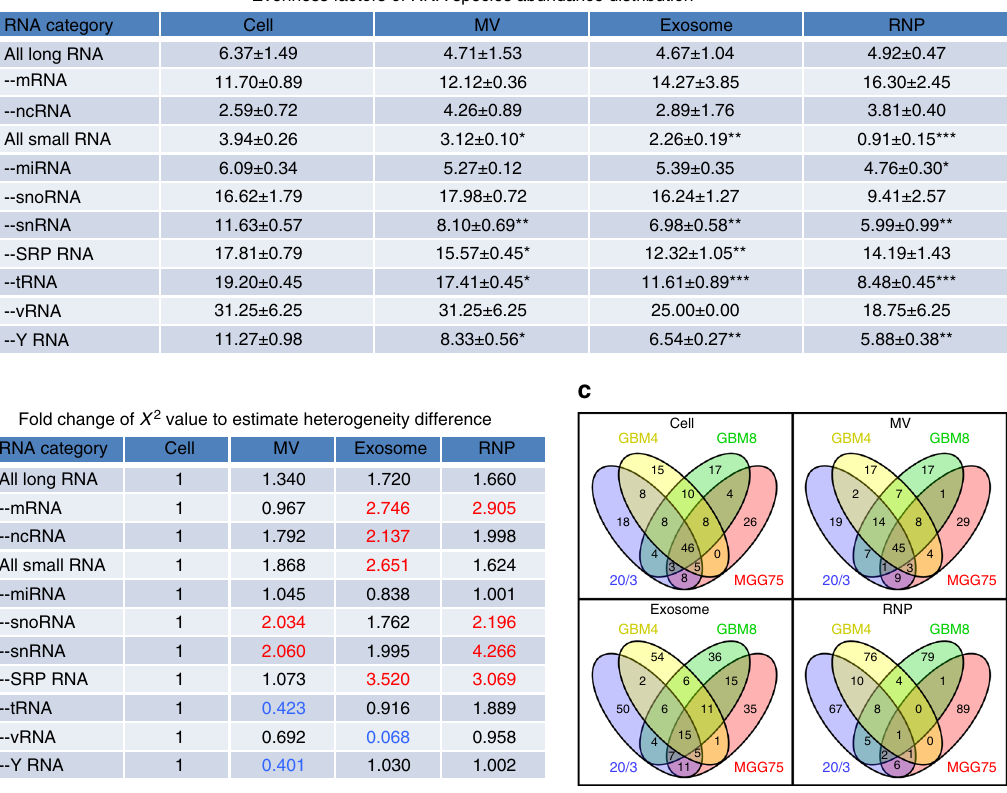
Fig. 5 Inequality and heterogeneity of the RNA repertoire of extracellular fractions. a Evenness factors, re fl ecting the inequality of abundance ’ distribution of the indicated RNA classes in various fractions. Higher evenness factors correspond to lower inequality. The classes of tRNA, Y RNA, snRNA, and SRP RNA, but not miRNA, contributed to the increased inequality of exRNA most signi fi cantly. Differential evenness factors of cellular and extracellular RNA suggest the selectivity of secretion ( n = 4 GSC cultures). b For each RNA category, a sum of squared errors ( χ 2 value) was calculated among four GBM cultures, after normalization of each RNA species to the total number of reads in that RNA category. The χ 2 value of each extracellular fraction was compared to the cellular fraction. Fold change of χ 2 values higher than 1 re fl ects the increased heterogeneity. Heterogeneity either increased or decreased more than two-fold is highlighted in red and blue, respectively. c Venn diagrams depict the number of common species among 100 top abundant mRNAs, in four GBM cultures and their extracellular fractions, supporting the observation of higher heterogeneity of mRNA composition in exRNA than in cellular RNA. Signi fi cant differences between the cellular and extracellular fractions are depicted as following: *, p < 0.05; **, p < 0.01; ***, p < 0.001; t